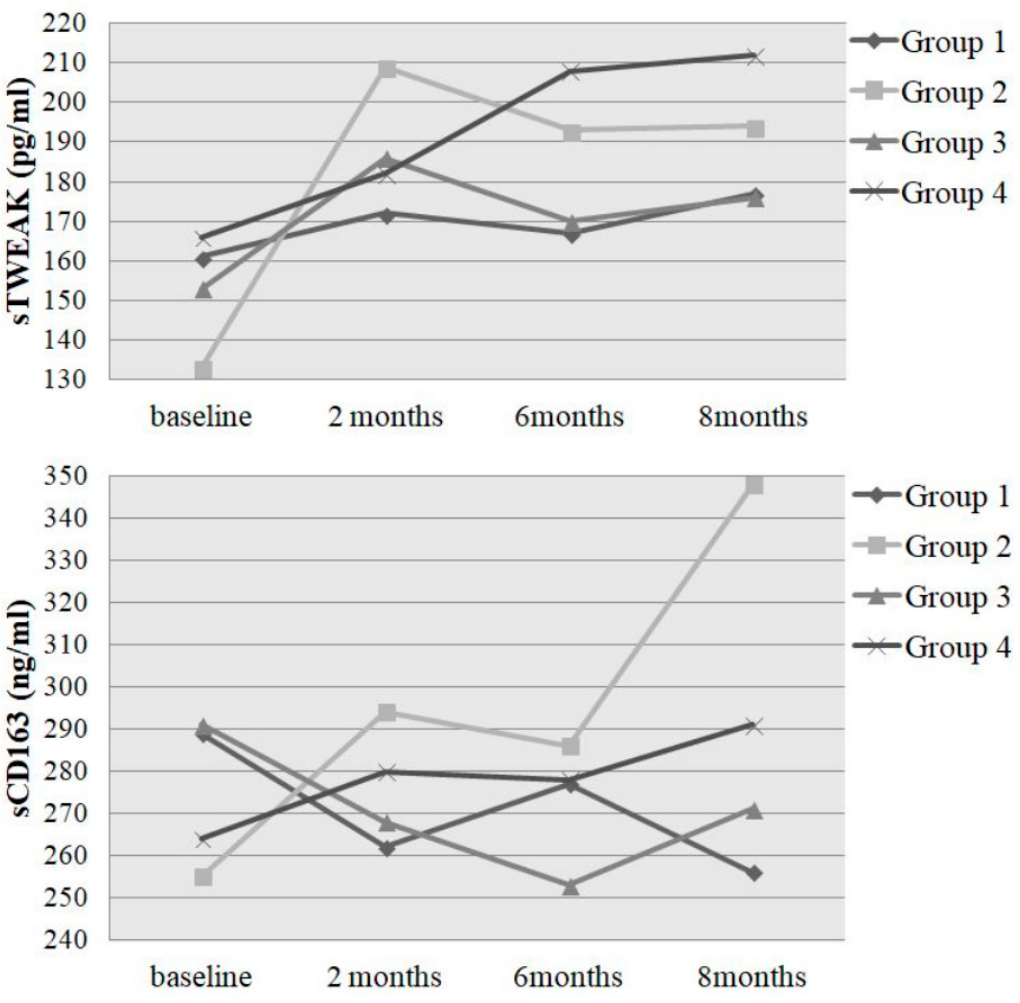
Figure 1. sTWEAK and sCD163 levels of the four groups over the observation time: data of the biomarkers are shown at baseline and after two, six and eight months of training. Data of the biomarkers are given as median. For greater clarity, the percentiles are not shown in the figure, but are shown in Table 3.